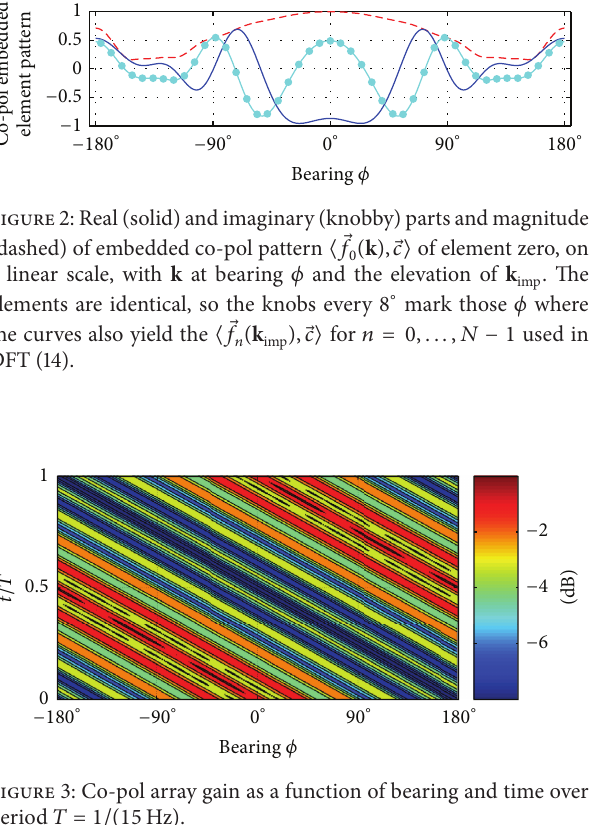
Figure 3: Co-pol array gain as a function of bearing and time over period 𝑇 = 1/(15 Hz )